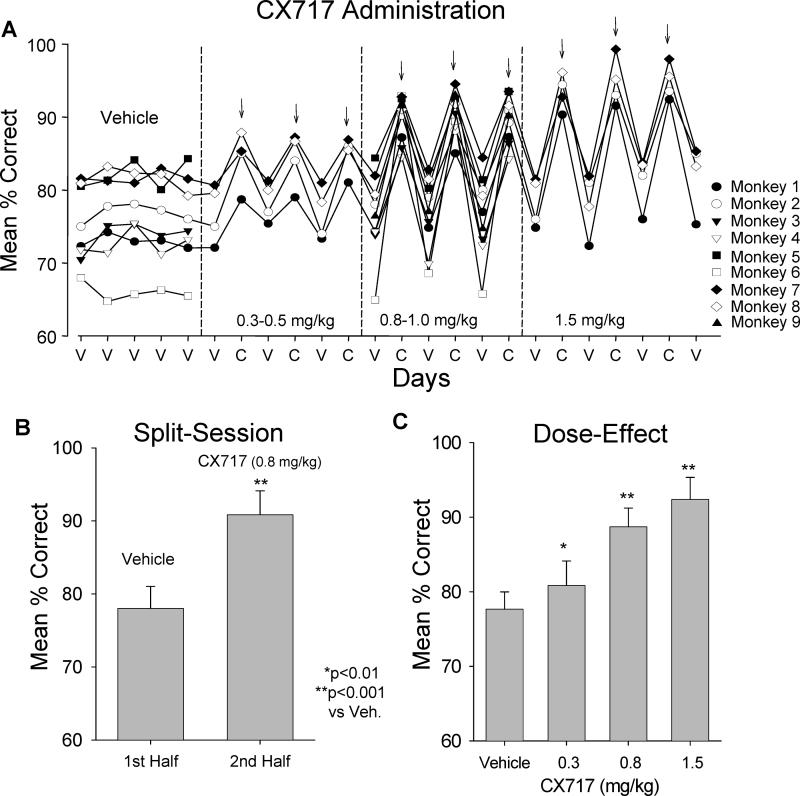
Effects of Different Doses of CX717 on DMS Performance in Normal + CX717 Condition(A) CX717 is shown administered on consecutive sessions for nine monkeys over three dose ranges of CX717 (0.3–0.5 mg/kg, 0.8–1.0 mg/kg, and 1.5 mg/kg, IV). Each CX717 session (C, arrows) was interspersed with a single normal vehicle (V) session. Curves show mean (± SEM) percent correct performance over the entire session from each different monkey, as indicated by separate symbols. Arrows indicate CX717 sessions (also denoted by “C” on axis). Note escalating doses (0.3, 0.8, and 1.5 mg/kg) shown were in four of the nine monkeys.(B) Performance on split sessions (n = 4 monkeys) in which vehicle was administered at the start of the DMS session, and midway through same session CX717 (0.8 mg/kg, IV) was administered via remote pump without interruption. Mean (± SEM) percent correct performance over at least 50 trials was calculated separately for the first half (vehicle) and second half (CX717, 0.8 mg/kg) of the same session. Asterisks indicate a significant (** p < 0.001) increase in the second half of the session relative to the first (vehicle).(C) Overall mean dose-effect relationship of CX717 on normal alert DMS performance across monkeys (n = 9) in sessions in which each of the three doses (0.3, 0.8, and 1.5 mg/kg, IV) was administered. DMS sessions in which the three doses were received in an escalating order were compared with sessions in which the same doses were administered in a randomized order (F[1,50] = 2.31, p = 13.5, NS). Asterisks indicate significant (*p < 0.01, **p < 0.001) difference relative to vehicle sessions.DOI: 10.1371/journal.pbio.0030299g003